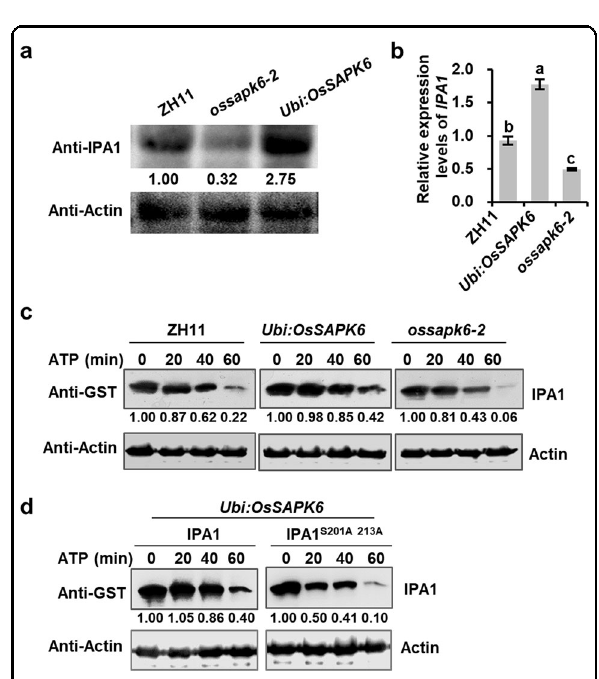
Fig. 3 OsSAPK6 enhances the stability of IPA1. a Protein levels of IPA1 in ZH11, Ubi:OsSAPK6 and ossapk6-2 2-week-old seedlings. b Expression levels of IPA1 in ZH11, Ubi:OsSAPK6 and ossapk6-2 2- week-old seedlings. Values are means ± SD ( n = 3 biological replicates) and the different letters indicate signi fi cant differences ( P < 0.01) according to Tukey ’ s honest signi fi cant difference (HSD) test. c In vitro cell-free degradation assays showing degradation of GST-IPA1 in extracts from ZH11, Ubi:OsSAPK6 , and ossapk6-2 plants in the presence of ATP. d In vitro cell-free degradation assay showing degradation of GST-IPA1 and GST-IPA1 S201A213A in the extracts from Ubi:OsSAPK6 plants in the presence of ATP. GST-IPA1 was detected with anti-GST monoclonal antibody and quantitated by densitometry with actin as a control. See also Supplementary Fig.